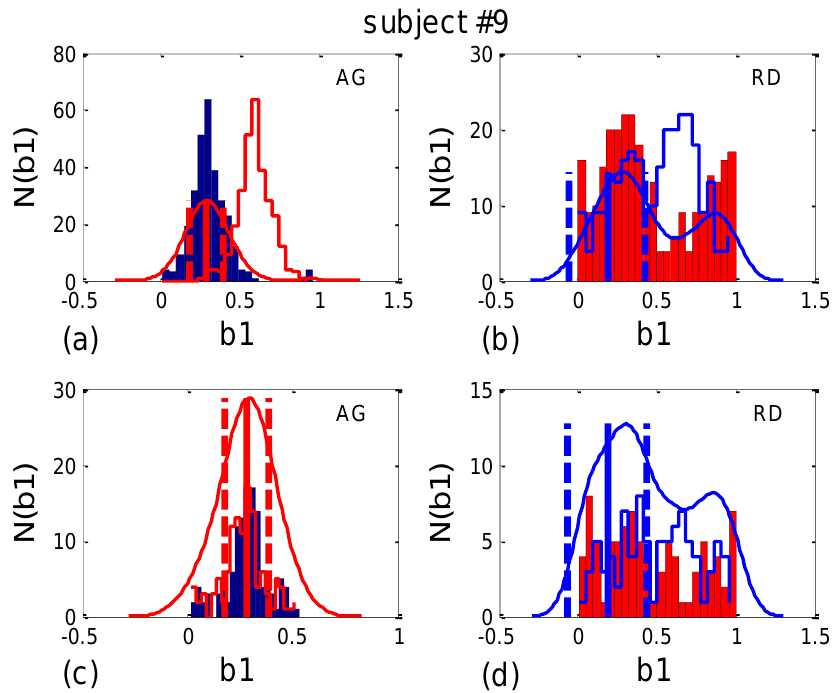
Figure 13. An example of the circular correction of the b1 histogram-derived standard deviation, denoted in the text as ( b1 hst ) c . ( a ) Supine; ( b ) standing; ( c ) supine with 0.1 Hz breathing; ( d ) standing with 0.1 Hz breathing. Their AG and RD codes are given in the right upper corner and the histograms are color-coded (AG — blue, RD — red). The PDE curves are drawn using opposite colors, for clarity. Centered histograms, having minimal standard deviation, are plotted as opposite-color open profiles. Angular mean values (vertical solid lines) are shown as ± circularly corrected standard deviation (vertical dashed lines).